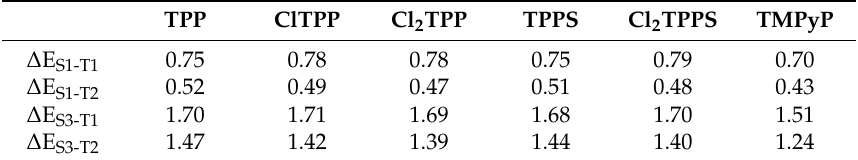
Table 2. Energy gaps ( ∆ E Sn − Tm eV) between the involved excited states calculated at the B3LYP / cc -pVDZ / M06 / 6 − 31G(d) levels of